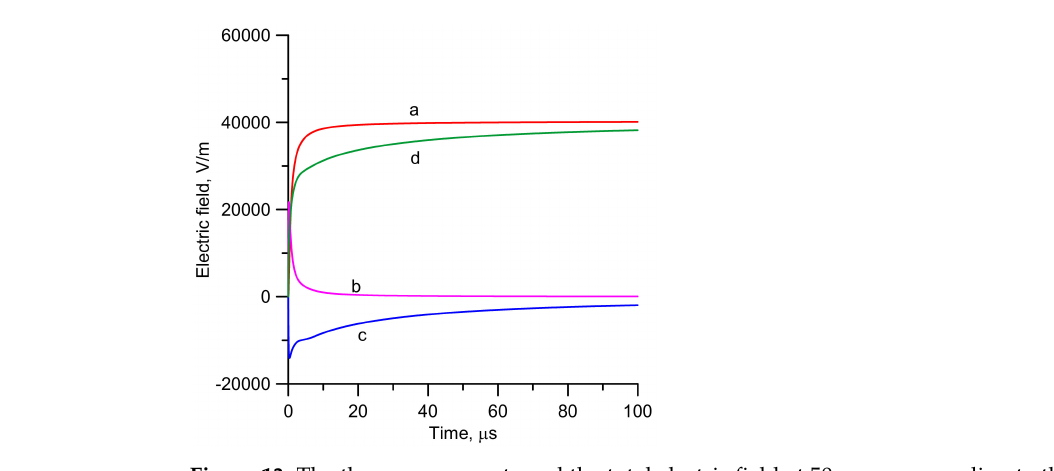
Figure 13. The three components and the total electric field at 50 m corresponding to the case with f = 1.0. ( a ) Static component, ( b ) radiation field generated by the initiation of corona currents, and ( c ) radiation field generated by the absorption of the corona currents at ground level. The total electric field is shown by the curve marked ( d ).